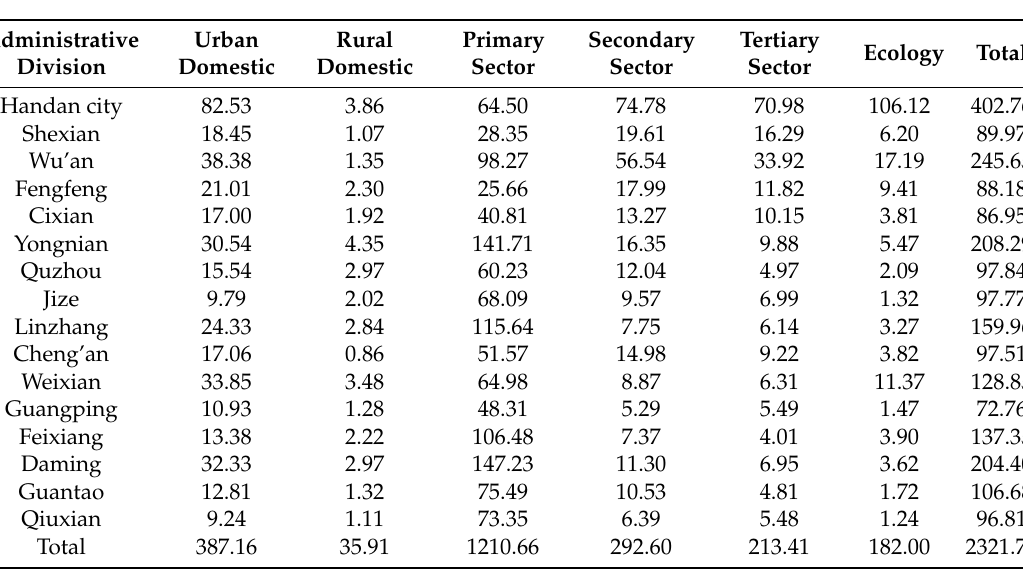
Table 14. Results for water allocation of AWOA (10 6 m 3